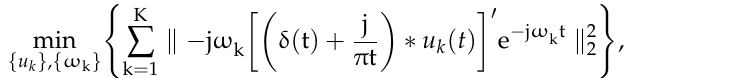
Figure 5. Phase difference: ( a ) in the time domain; ( b ) in the frequency domain.